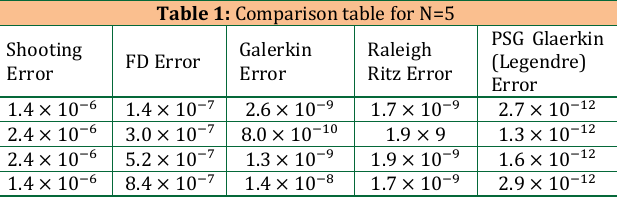
Table 1: Comparison table for N=5